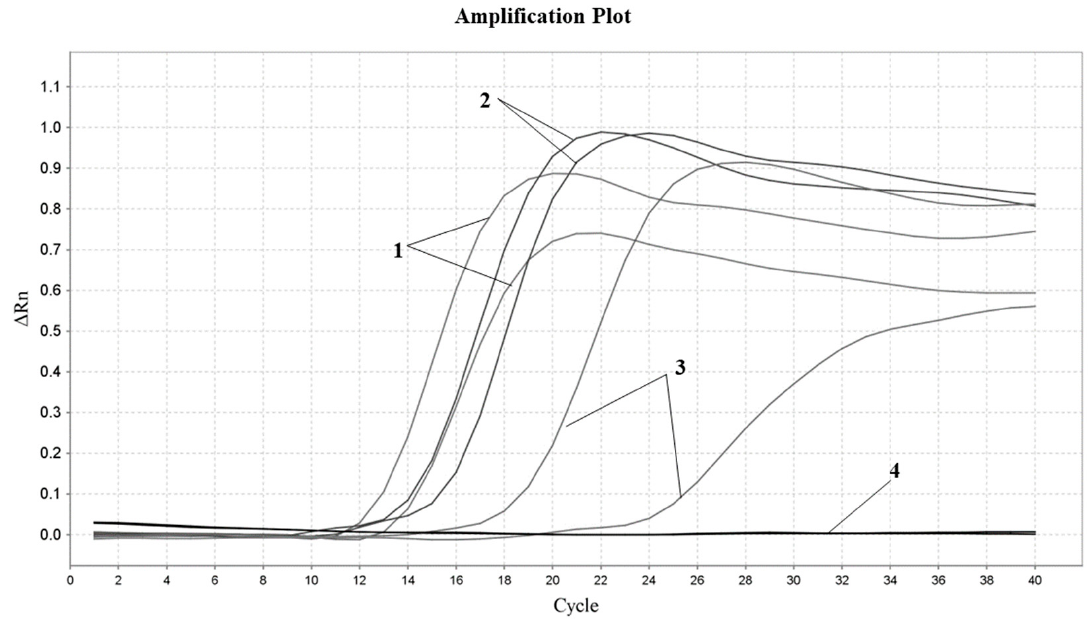
Figure 3. Proofman–LMTIA response sensitivity test for ITS gene in soybean. Varying amounts of gDNAs of the following: 1: soybean 100 pg/ μ L; 2: soybean 10 pg/ μ L; 3: soybean 1 pg/ μ L; 4: ddH 2